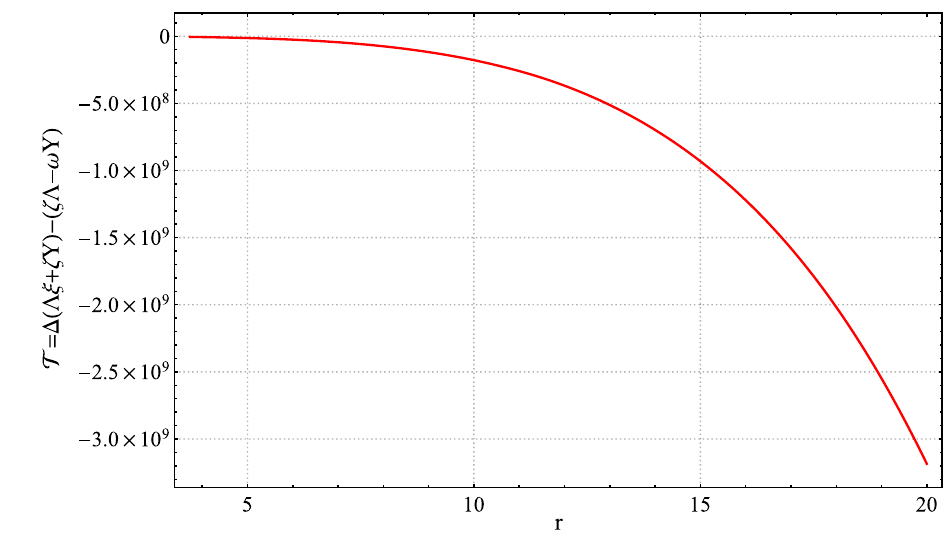
Fig. 1 The plot of T − r out of the horizon, where we set j